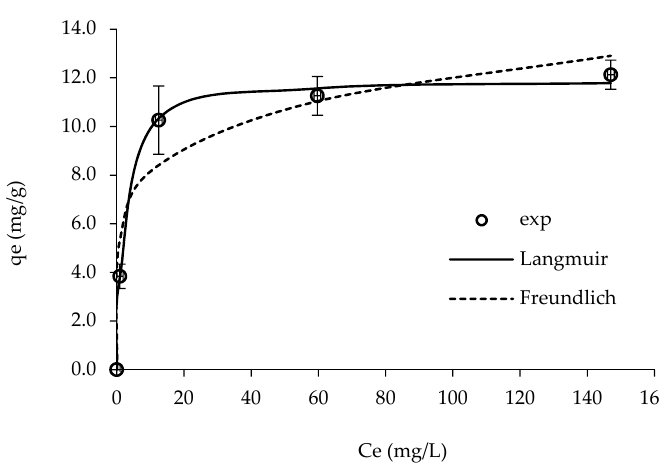
Figure 8. Experimental data and fits of the Langmuir and Freundlich models for the adsorption of RY on ST-derived char. Conditions: contact time = 150 min; solution pH = 6.0 (natural); char dosage = 4 g / dm 3 . Exp—experimental data. Error bars of duplicates are shown.